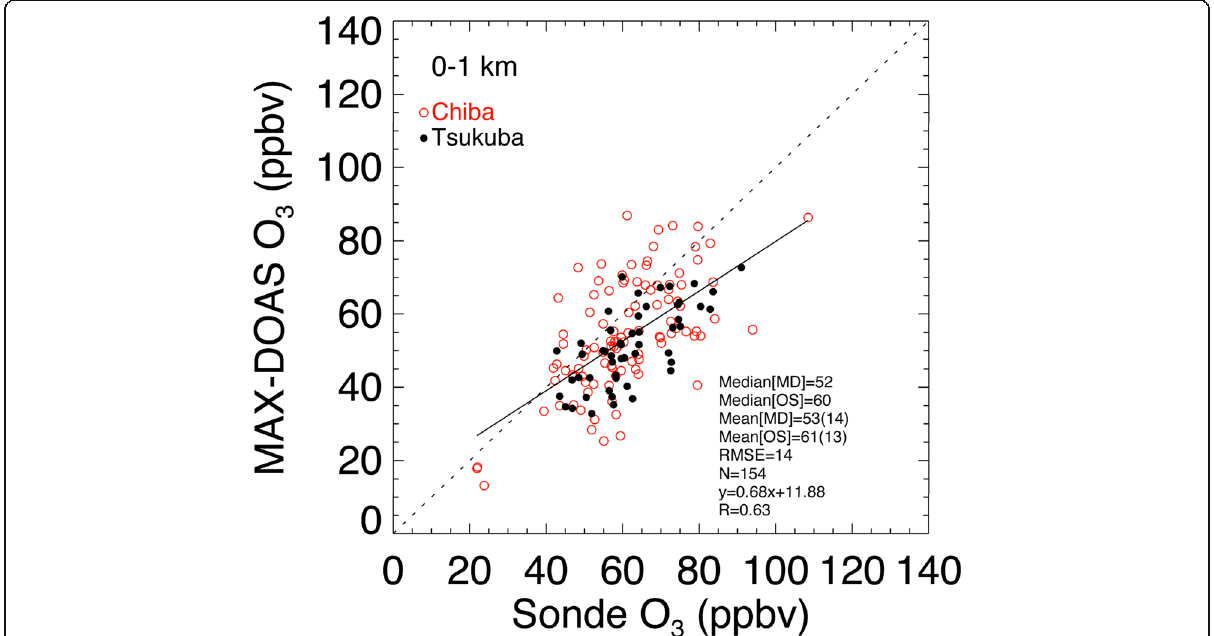
Fig. 3 Correlations between the ozonesonde and MAX-DOAS O 3 concentration data shown in Fig. 2. Their medians, means, and 1- σ standard deviations (in brackets after the means) are given. The root-mean-square error, number of comparisons, and equation of the linear least-squares fitting, and correlation coefficient are given. The linear least-squares fitting and 1:1 lines are shown by solid and dashed lines,